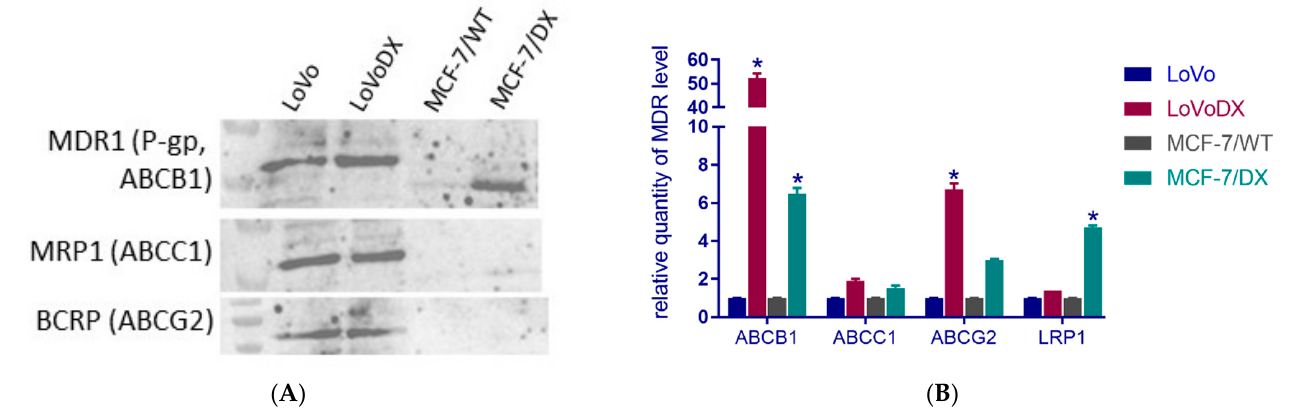
Figure 2. The level of MDR proteins in human and colon and breast cancer ( A ), relative quantity level of MDR genes expression ( B ). Asterisk (*) corresponds to statistically significant ( p < 0.05)